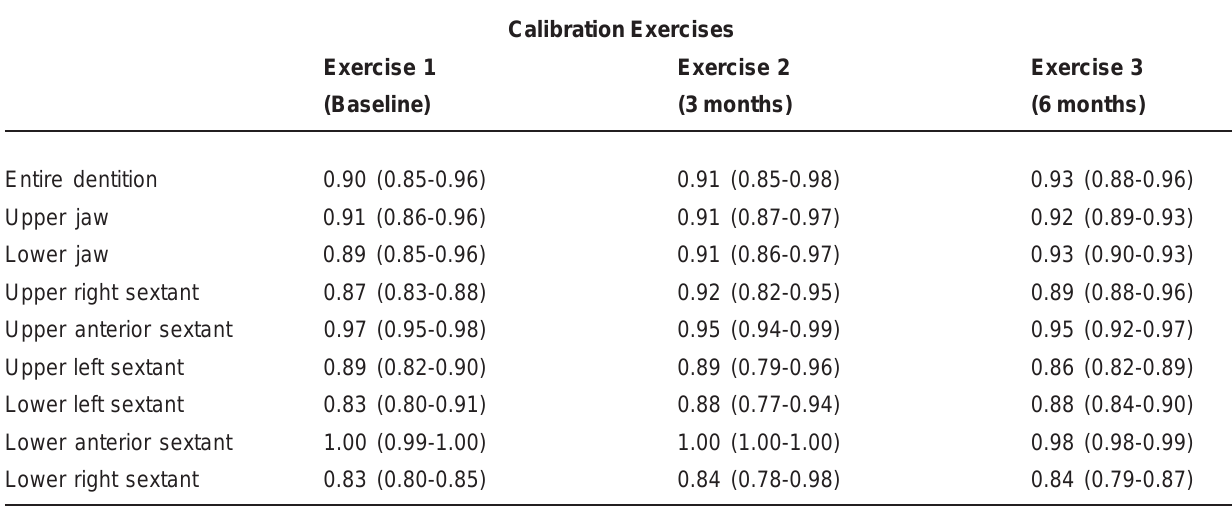
TABLE 2- Mean Kappa values for interexaminer reliability (interval of variation) under the WHO+IL caries diagnosis threshold, considering the entire dentition, jaws and sextants according to calibration exercises. Piracicaba, 2004